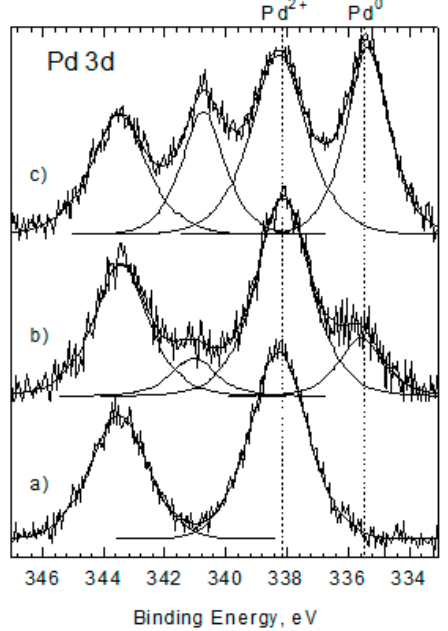
Figure 1. Pd 3d core level spectra for Pd(OAc) 2 as reference ( a ), Pd/DNA (C1) prepared at RT ( b ), and Pd/DNA (C2) prepared at 80 °C ( c ).